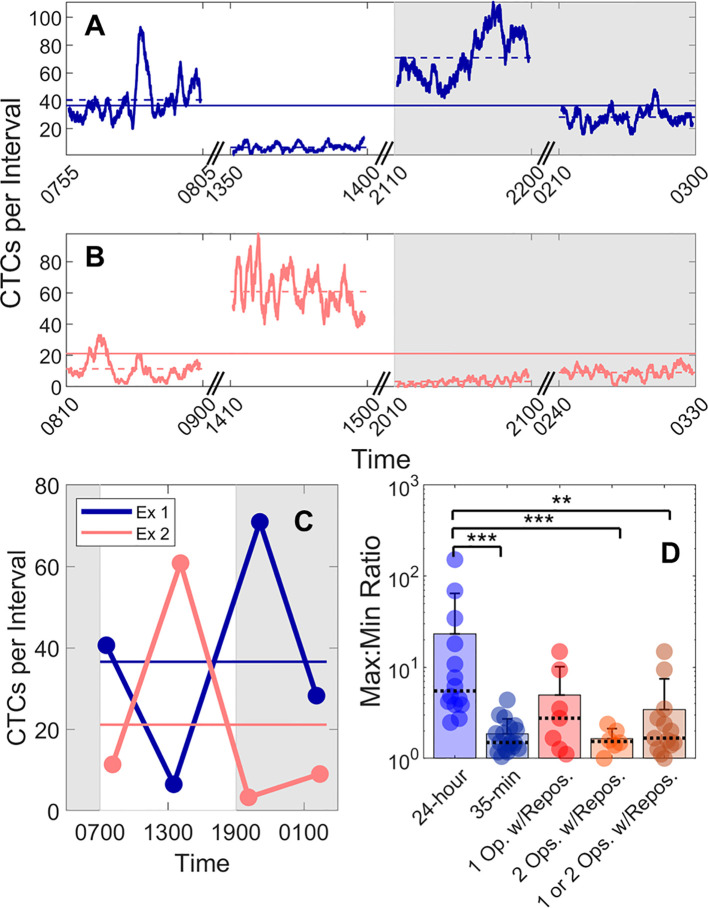
Large fluctuations in CTC numbers were observed over 24-h cycles. (A, B) Example DiFC measurements taken over 24 h in two MM-bearing mice. The number of CTCs counted in 2 min (5% PBV) sliding intervals is shown. The solid horizontal lines in each figure show the 24-h mean number of CTCs per 2 min interval, and the dashed horizontal lines show the local mean of the 50-min DiFC scan. Dark hours are shaded gray. (C) The mean DiFC count rates over the 24-h period are shown. (D) Ratios of maximum-to-minimum DiFC count rates are shown for MM 24-h, MM 35-min (no repositioning), 1-operator-with-reposition, and 2-operators-with-reposition data sets. Bars represent the mean values with standard deviation error bars and dotted lines to identify the median values. Note the logarithmic y-axis. Kolmogorov-Smirnov test significance indicated by ** (p-value < 0.01) and *** (p-value < 0.001).